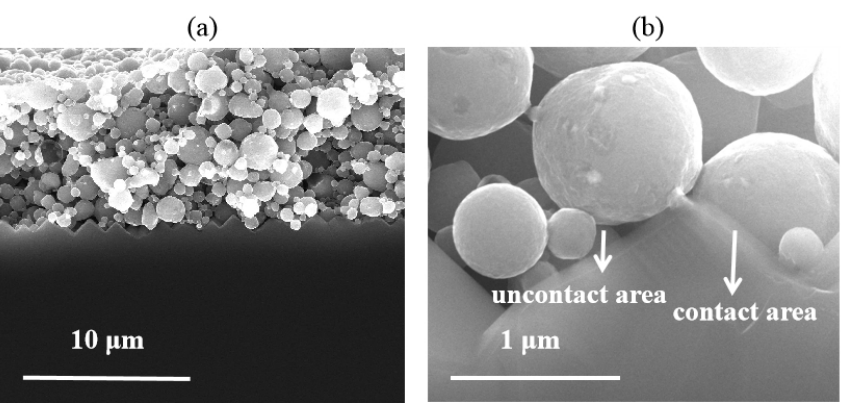
Figure 9. Cross-section SEM images obtained at the metallization/Si contact area of Cell 2: ( a ) low-magnification images; ( b ) high-magnification images. The SEM images show a discontinuous contact between the firing-through Al paste and Si substrate of Cell